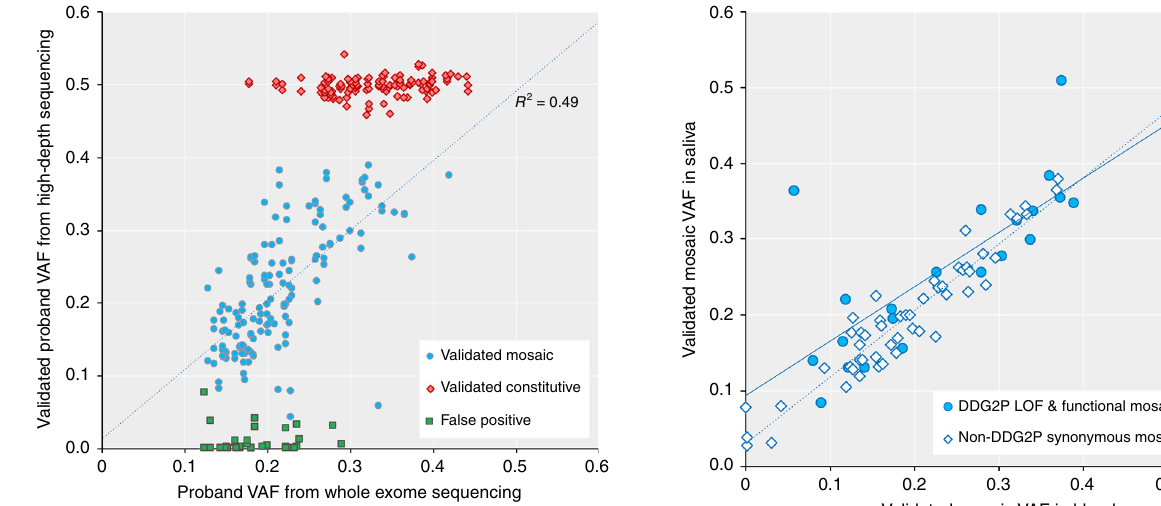
Fig. 4 Levels of mosaicism in saliva versus blood Comparison of the validated mosaic fraction using ultrahigh-depth sequencing in blood. versus saliva for mosaic DNMs that are either plausibly pathogenic loss-of- function (LOF) or functional variants in known developmental disorder genes (DDG2P, open diamonds), or likely benign synonymous variants in genes not currently associated with developmental disorders (not-DDG2P, fi lled circles). There is generally a good correlation between saliva and blood VAFs (DDG2P functional, solid line, R 2 = 0.6; non-DDG2P synonymous, dotted line, R 2 = 0.9) and there is no signi fi cant difference between the association of mosaic VAF in saliva versus blood using linear regression and including DDG2P status as a covariate